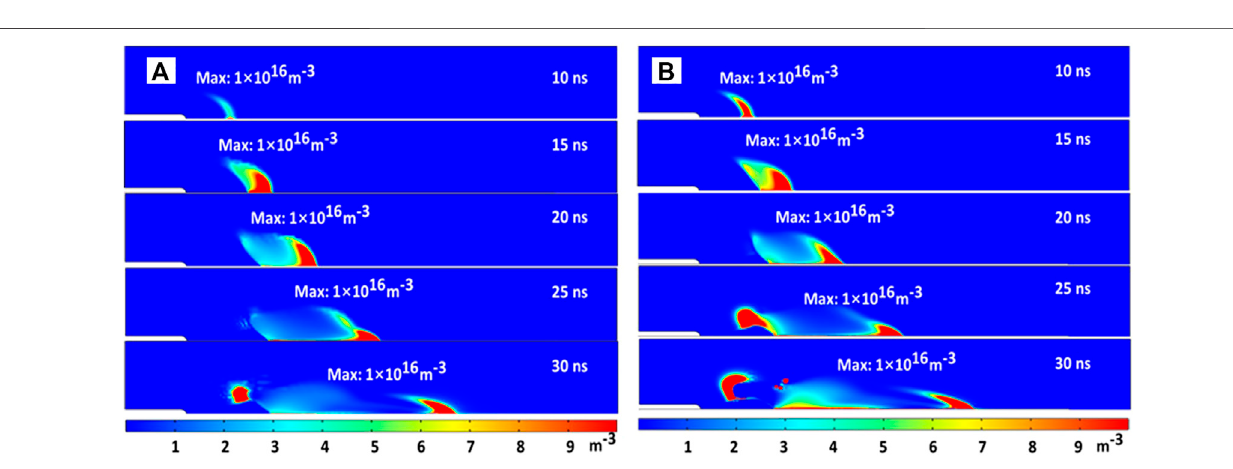
FIGURE 9 | The spatiotemporal evolution of N 2+ density with uniform permittivity (A) and graded permittivity (B) dielectric barrier.